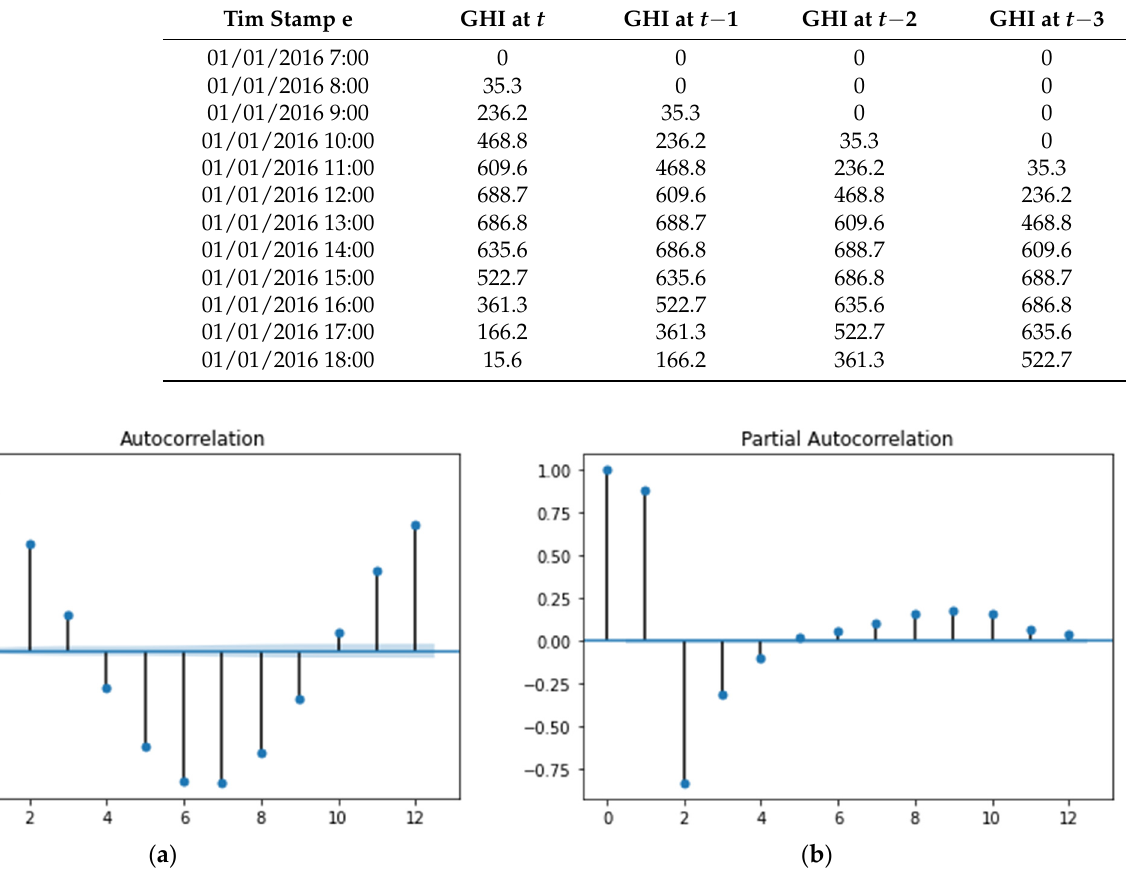
Figure 8. ( a ) Autocorrelation function. ( b ) Partial autocorrelation function of GHI and its lagged readings.